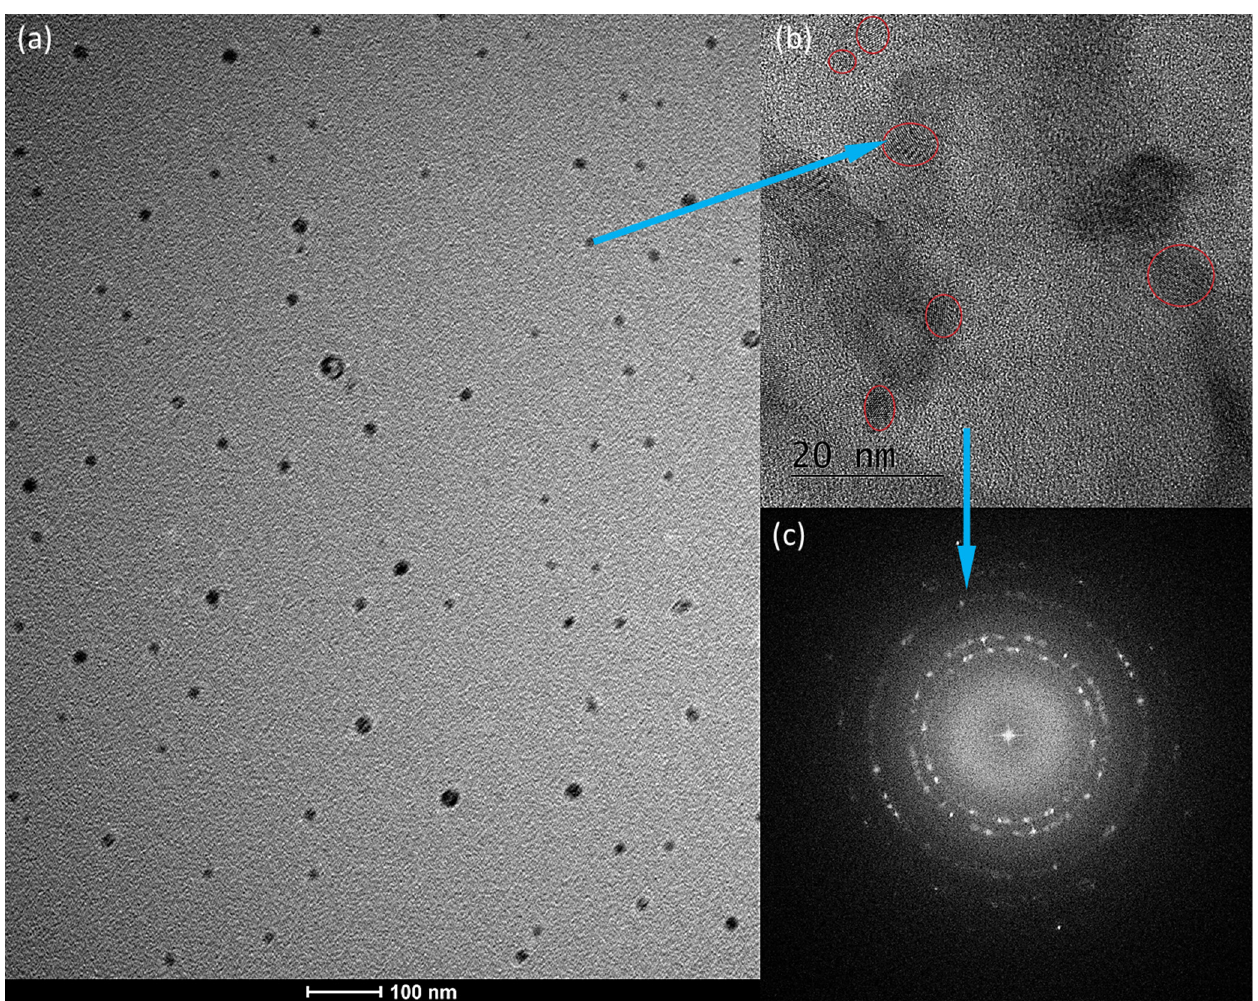
Figure 1. TEM micrographs of CdSe QDs displaying lattice fringes and diffraction pattern. ( a ) TEM overview of cluster CdSe QDs coated with PVP. ( b ) HR-TEM (inset) showing lattice fringes of ordered CdSe QDs. ( c ) Diffraction pattern showing crystal structure of CdSe QDs to third order, which is typical of CdSe crystals.